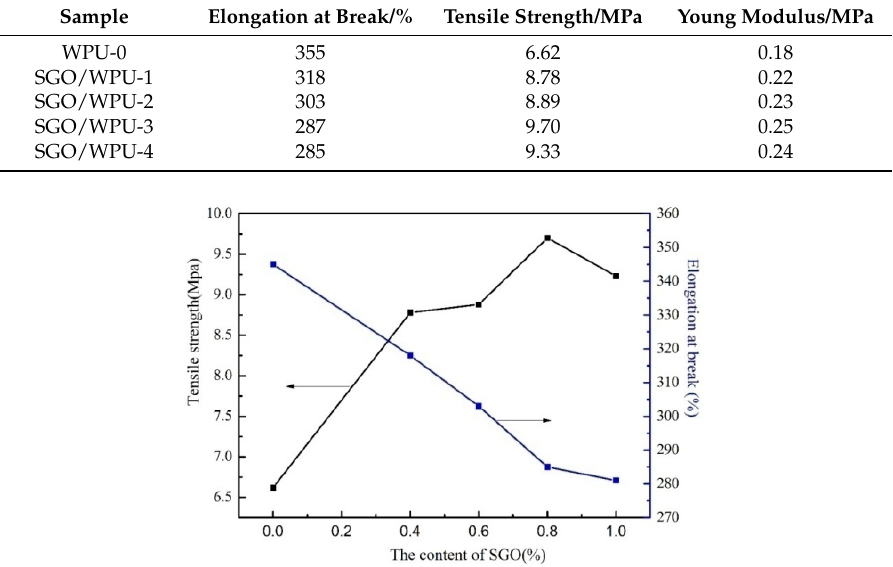
Table 2. Mechanical properties of SGO/WPU composites with different SGO contents.